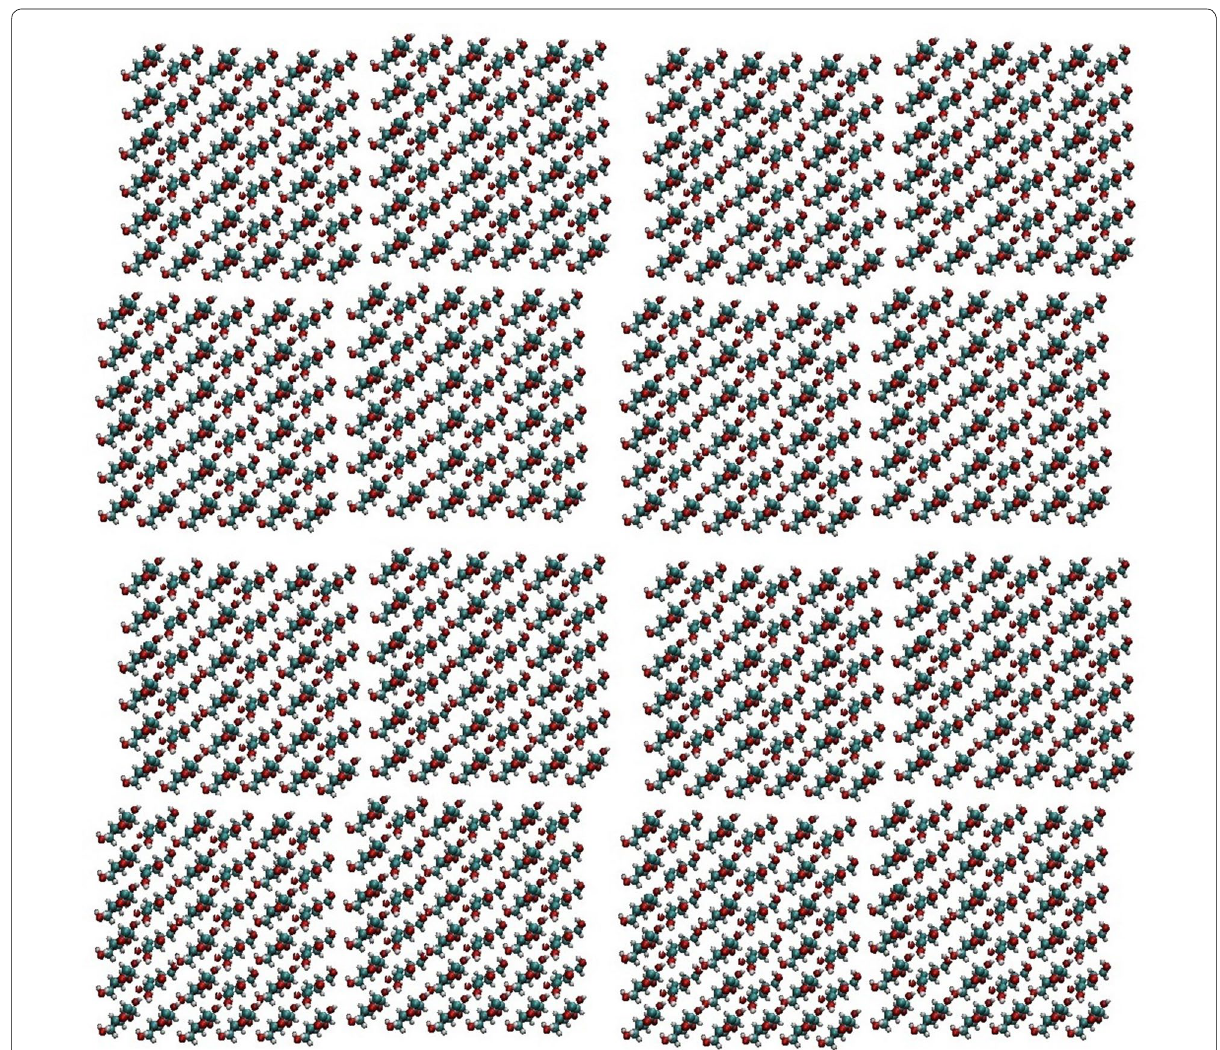
Fig. 1 Cross-sectional diagram of cellulose macrofibril, consisting of MF aggregates, each of which contains 4